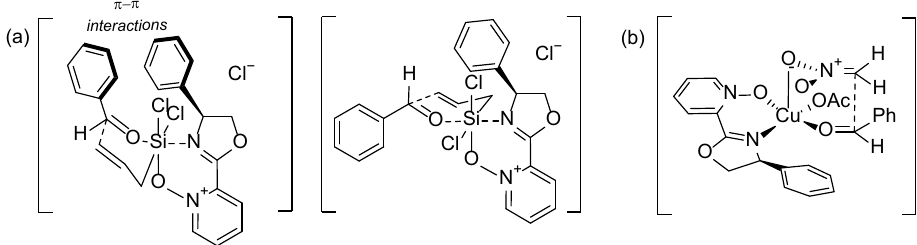
Figure 2. Representation of the possible transition state structures in allylation reaction ( a ) and nitroaldol reaction ( b ).